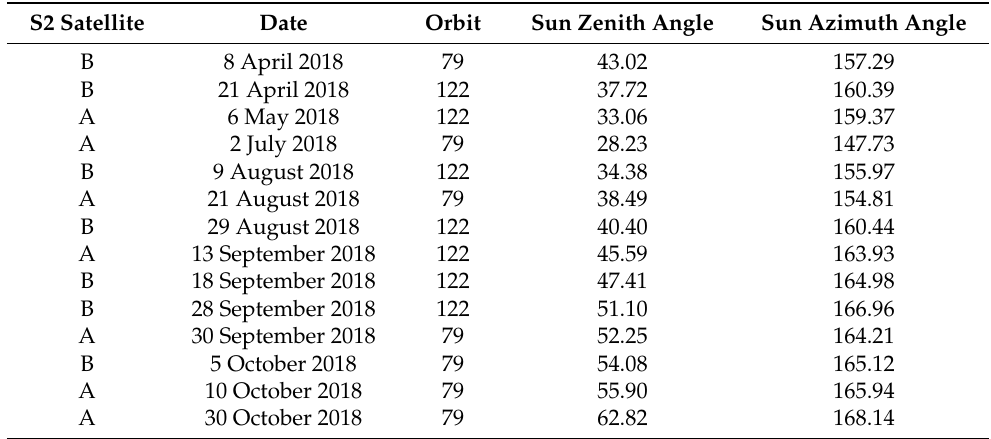
Table 1. Summary of the Sentinel-2 (S2) scenes of the 2018 vegetation period used for